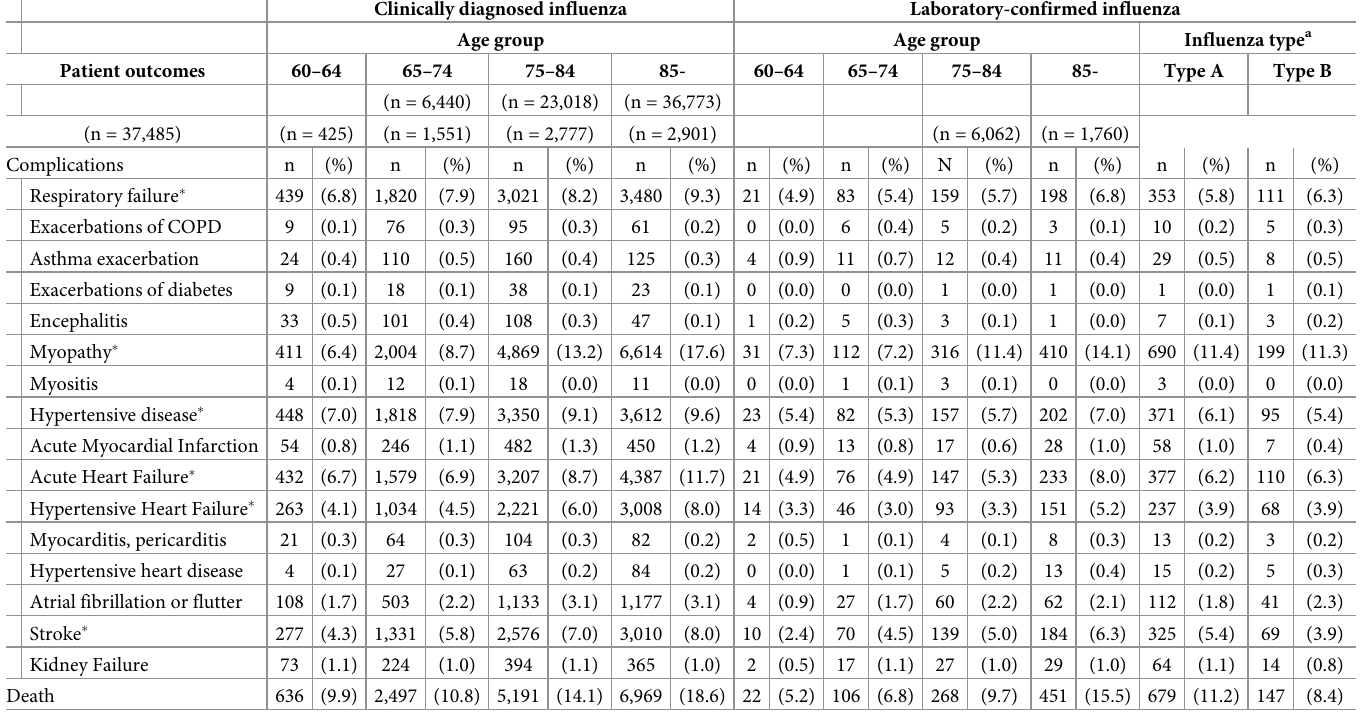
Table 4. Complications and deaths among patients hospitalized with clinically diagnosed and laboratory-confirmed influenza by age group and influenza type, from 2010/2011–2018/2019